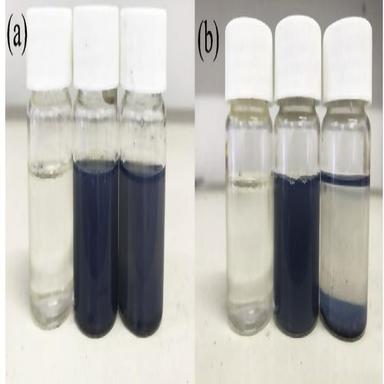
Digital photos showing dispersion stability of CaCl2·6H2O (left), CaCl2·6H2O/CsxWO3 with (middle) and without (right) CTAB and after 48 h.